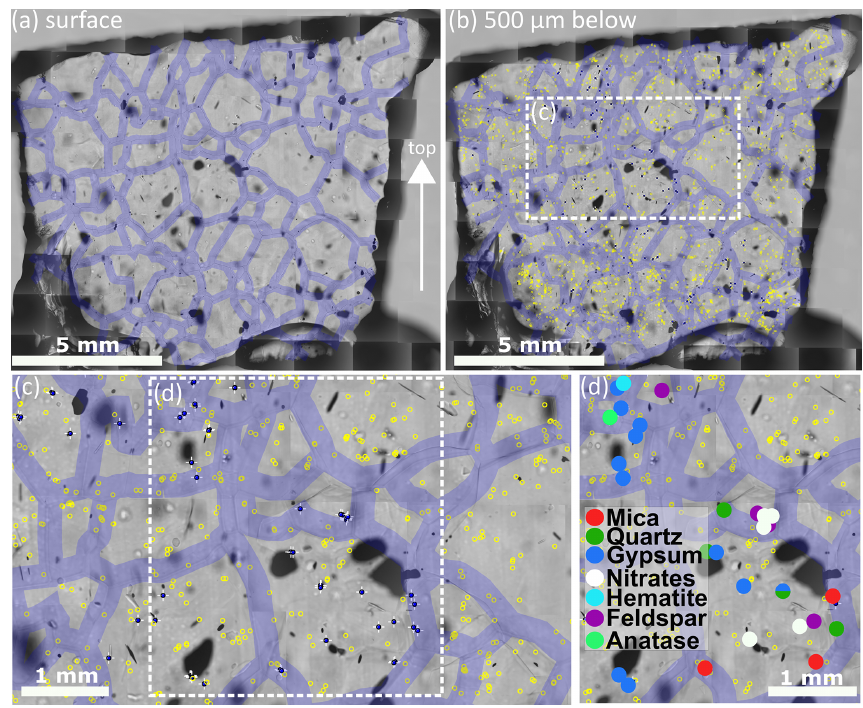
Figure 3. Details of the analysis procedure on S11 (1339.75m). Grain boundaries are indicated with 300µm thick violet lines. Localised micro-inclusions 500µm below the surface are indicated by yellow circles; micro-inclusions analysed with Raman spectroscopy are indicated by filled blue circles with white crosses. Out of focus black shapes are air bubbles. (a) Map of the sample surface with highlighted grain boundaries; the arrow indicates the surface of the ice sheet. (b) Impurity map with a focus depth of 500µm below the sample surface; micro- inclusions and grain boundaries are indicated. (c) Detail of the area indicated in (b) . (d) Identified Raman spectra of the micro-inclusions indicated in (c) . One inclusion consists of a quartz and a gypsum spectrum